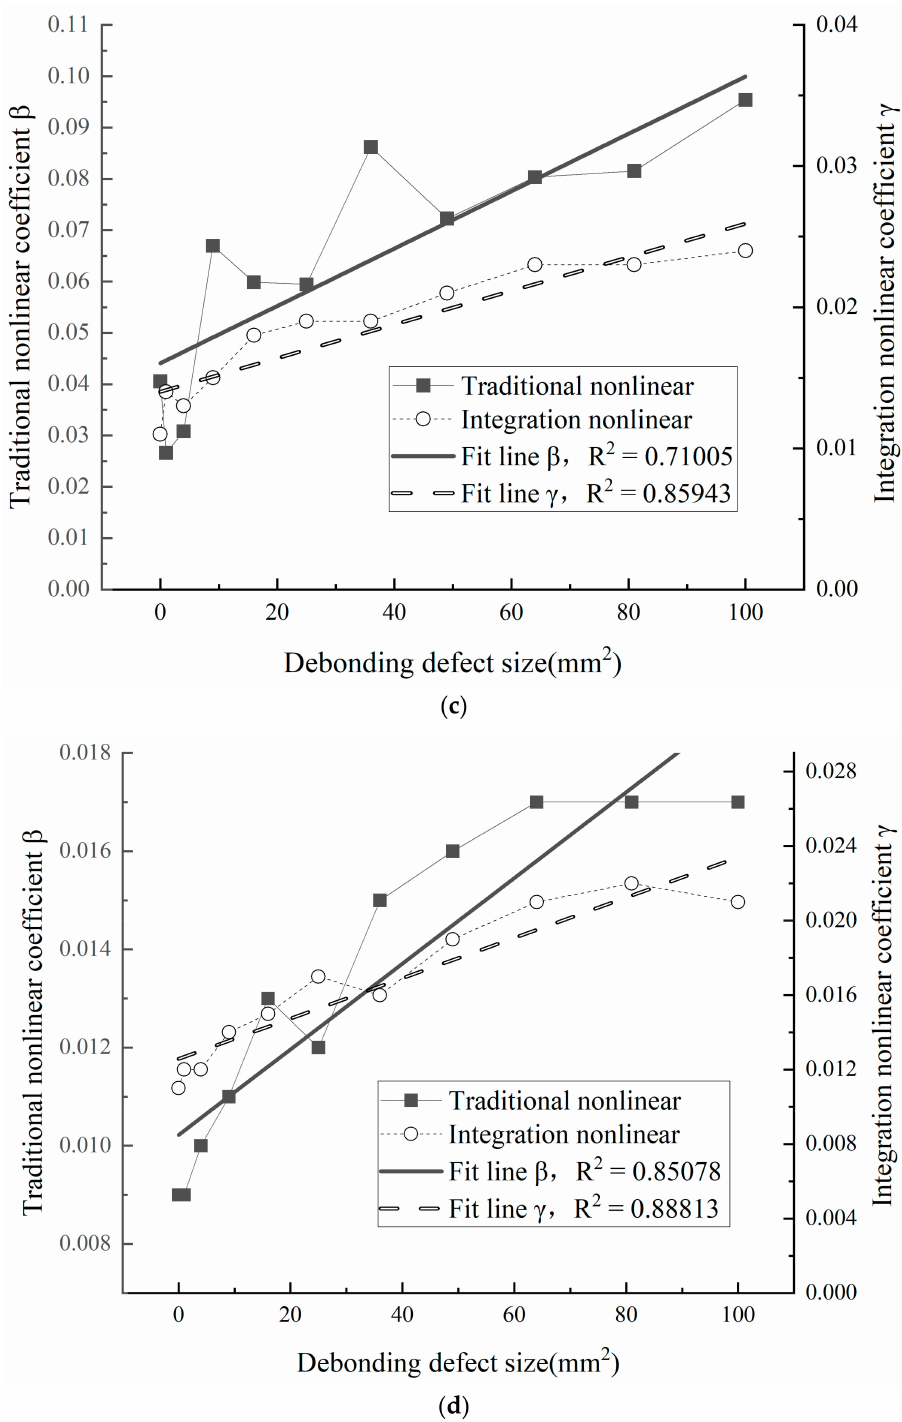
Figure 6. Fitting curves of the relation between defect size and relative nonlinear coefficient of four samples: ( a ) 1#sample, ( b ) 2#sample, ( c ) 3#sample, ( d )